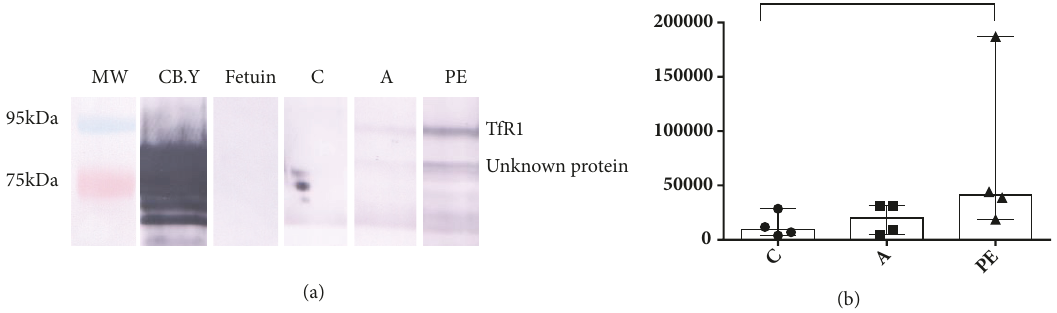
Figure 4: Expression pattern of mannose detected by the GNA lectin. (a) Representative image of a lectin blot; as positive control carboxypeptidase Y (CB.Y) was used, and as negative control fetuin. (b) Expression of the mannose pattern of TfR1 in trophoblastic villi in the control group (C), the group with IDAP (A), and the group with early-onset severe preeclampsia (PE). The data are presented as median and range, Kruskal-Wallis statistical analysis, where p < 0.05 ∗